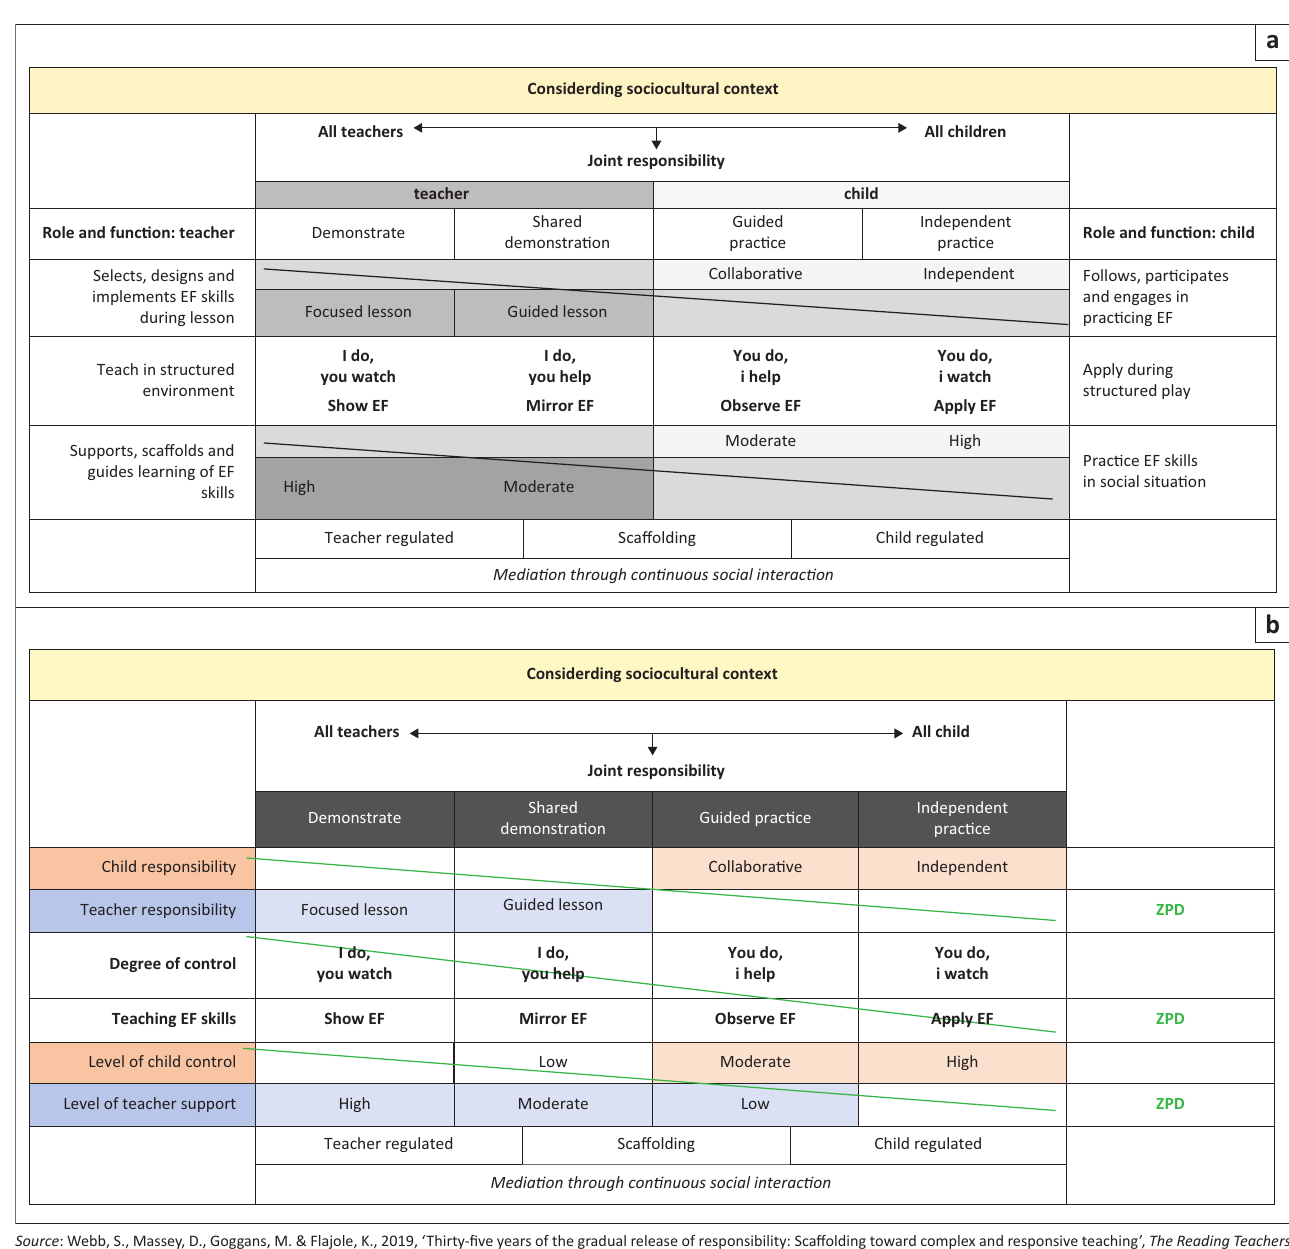
FIGURE 1: Zone of proximal development embedded within executive function